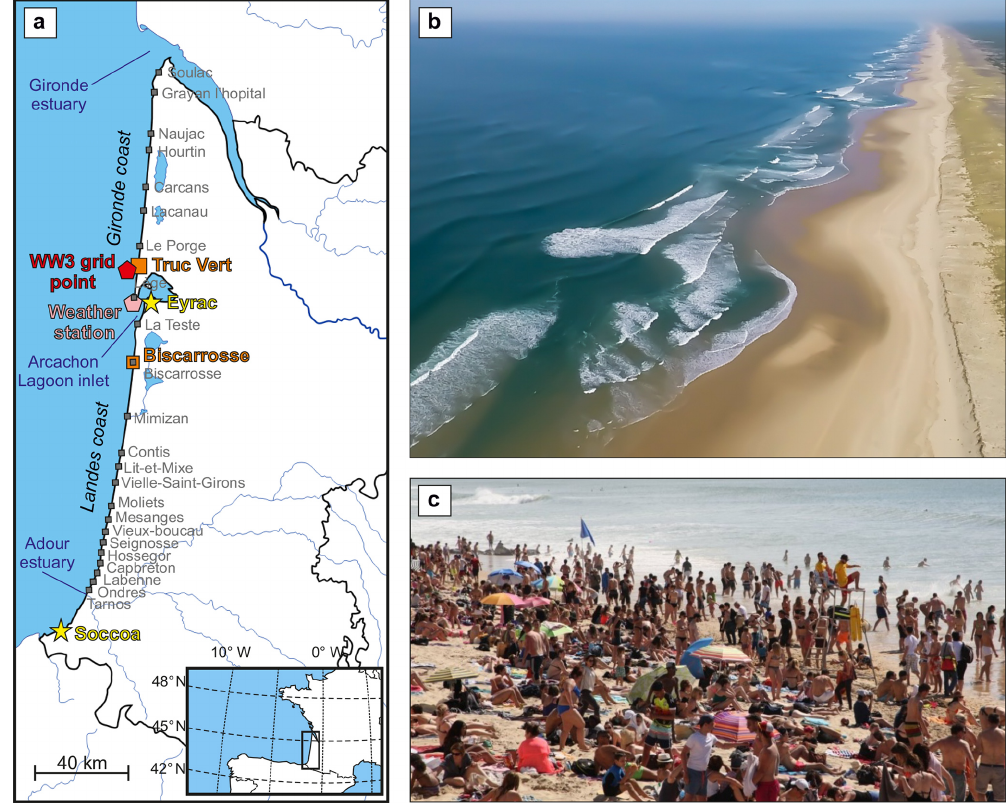
Figure 1. (a) Location map of southwestern France showing the 230km long sandy beach study location encompassing the Gironde and Landes coasts between the Adour and Gironde estuaries. Grey squares indicate coastal municipalities where incident or injury report forms were gathered, yellow stars indicate tide gauges, and the red and pink polygons show the location of the Wave Watch III (WW3) model output grid point and weather station, respectively. (b) Aerial photograph of Truc Vert beach taken at low tide, showing a landscape representative of the southwestern French beaches with deep rip channels and steeper upper beach slopes (Ph. Vincent Marieu). (c) Crowded beach during summer at high tide with lifeguards supervising a bathing area delimited by two blue flags, typically extending no more than 100m alongshore (Ph. Julien